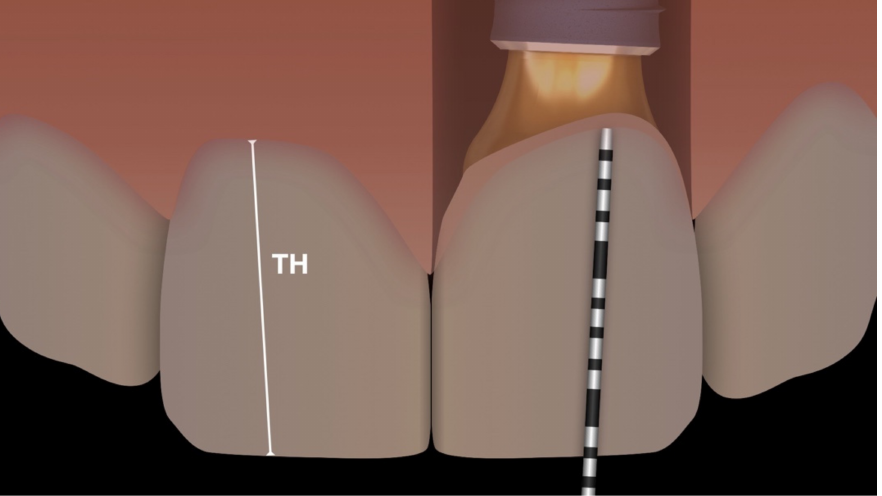
Figure 5. TH measurement through the probe. tooth height (TH) measured as the distance between the buccal gingival zenith and the crown incisal edge, according to the main axis of the